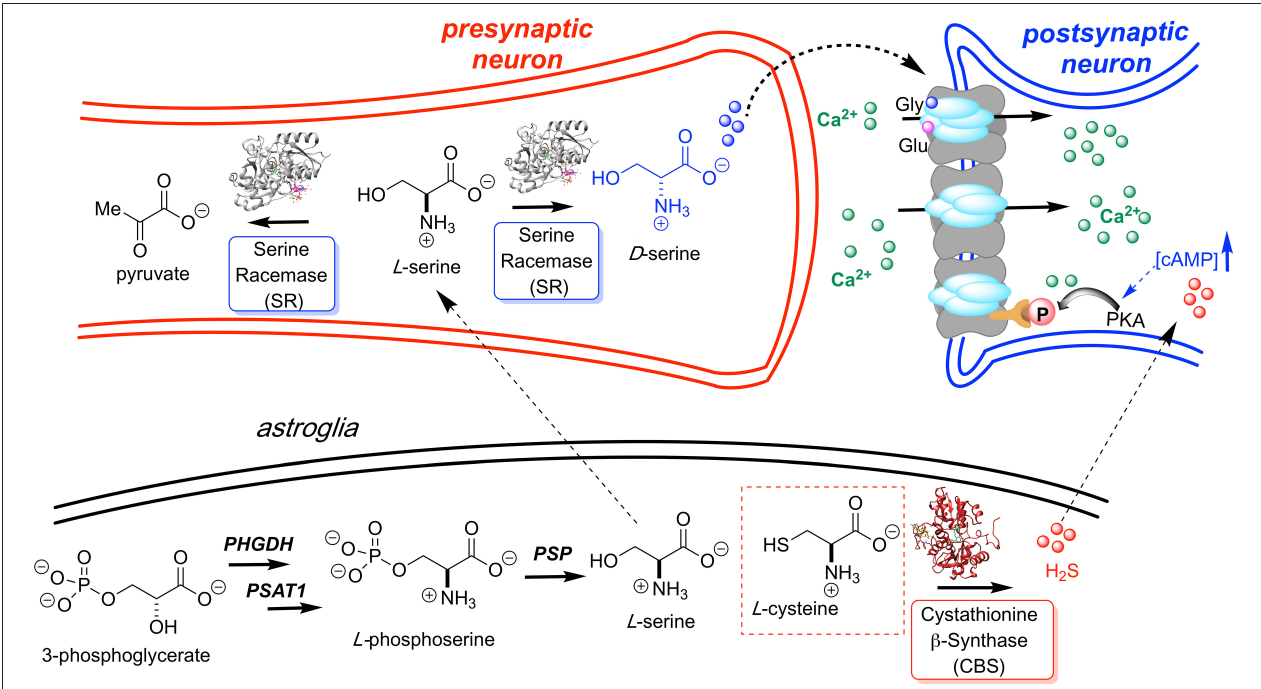
FIGURE 1 | L-Serine is first produced in the astroglia from 3-phosphoglycerate by way of a three enzyme cascade involving phosphoglycerate dehydrogenase (PHGDH), phosphoserine aminotransferase 1 (PSAT1), and phosphoserine phosphatase (PSP). L-Serine is then transported to the presynaptic neuron where it is converted to D-Ser by hSR. D-Serine acts as a potent NMDAR co-agonist at the glycine site. H 2 S, generated by CBS, is also thought to activate the NMDA receptor. Models for H 2 S-NMDAR activation include a cAMP-dependent PKA-mediated phosphorylation and H 2 S- or sulfane sulfur-mediated NMDAR disulfide bond reduction ( Kimura, 2000; Kimura et al.,